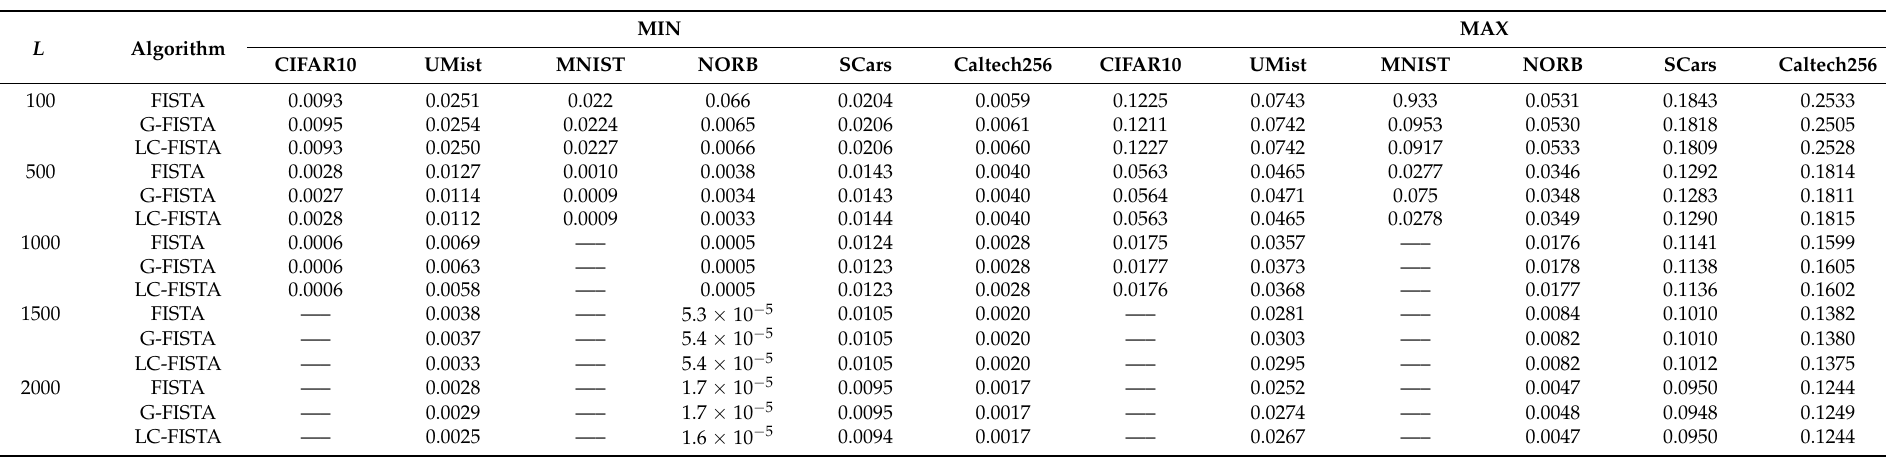
Table 7. MIN and MAX values achieved by FISTA, G-FISTA and LC-FISTA for training of the